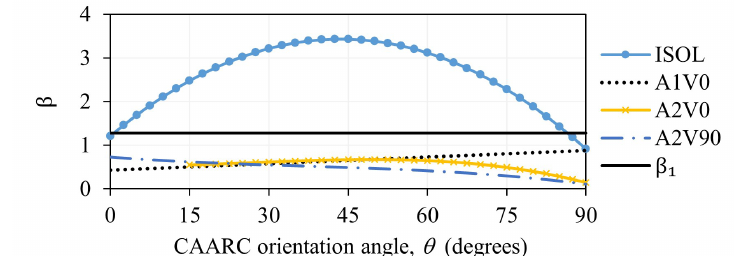
Figure 8. Reliability index β for acceleration, x-direction – limit criterion of 4.8 cm/s 2